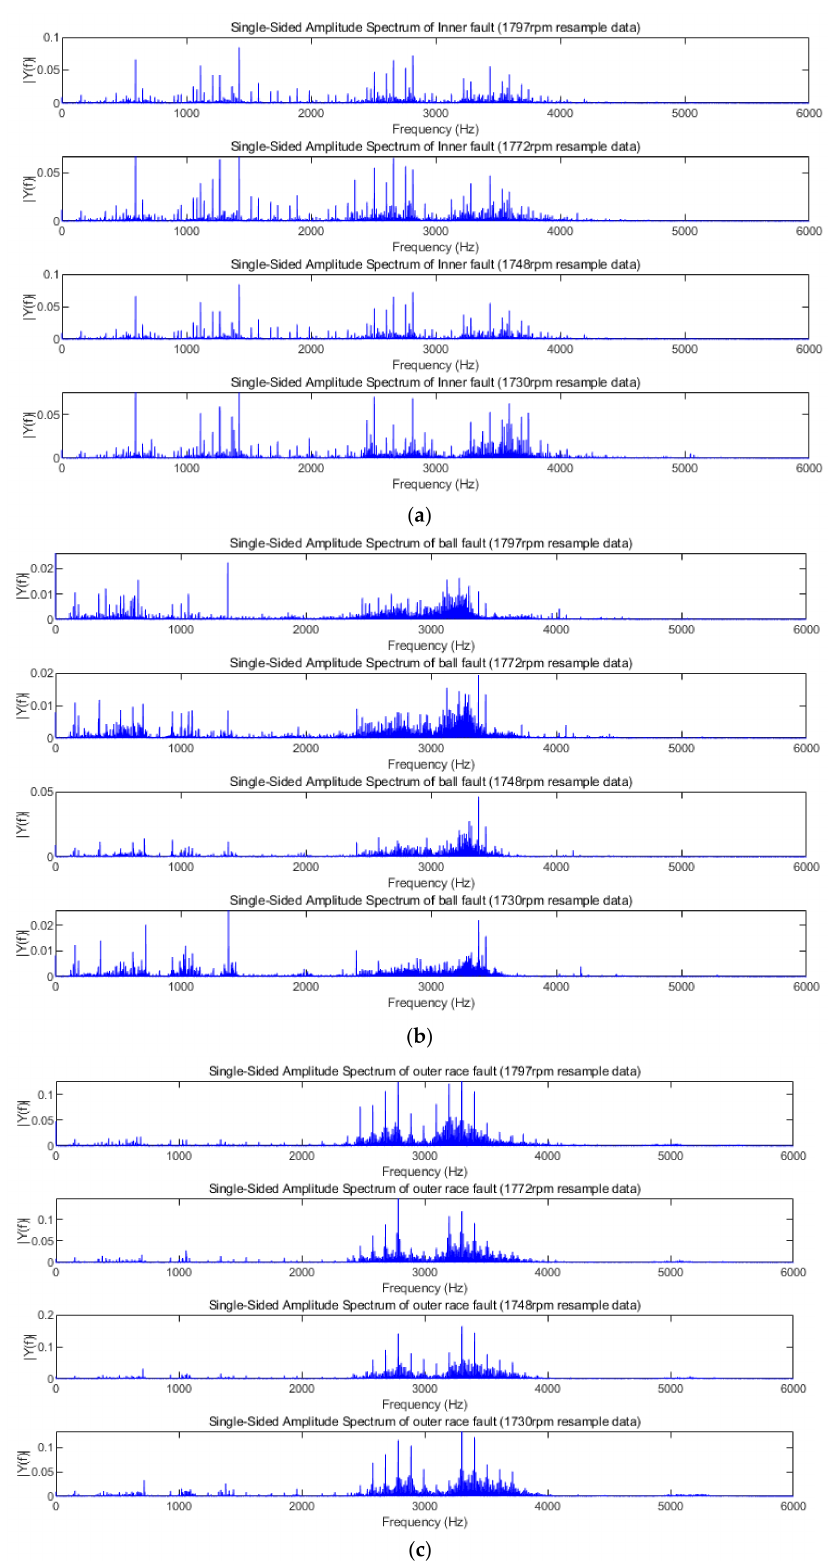
Figure 9. The spectral characteristics of resampling data at each speed. ( a ) Spectrum of inner race fault resampling data at each speed; ( b ) spectrum of ball fault resampling data at each speed; ( c ) spectrum of outer race fault resampling data at each